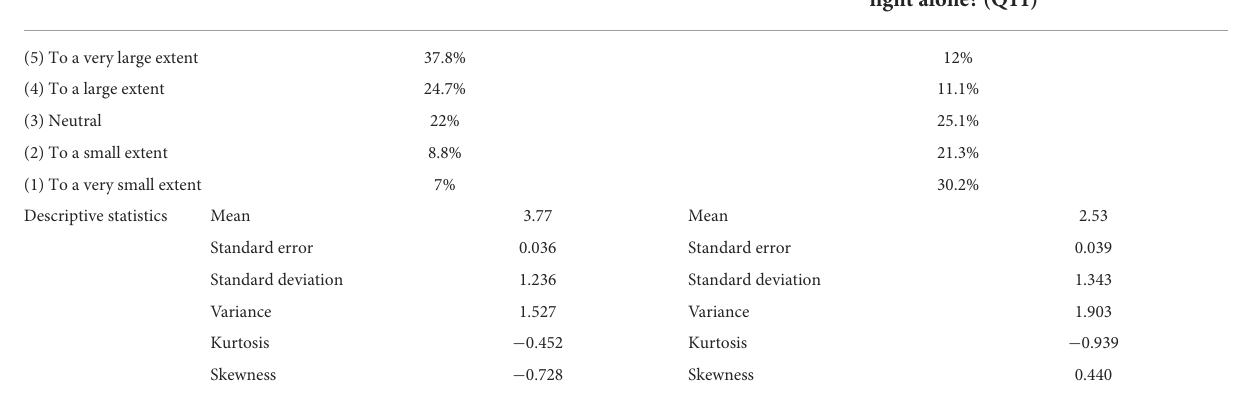
TABLE 7 The opinion of the participants regarding the NATO response in case of an invasion of Romania by the Russian Federation.